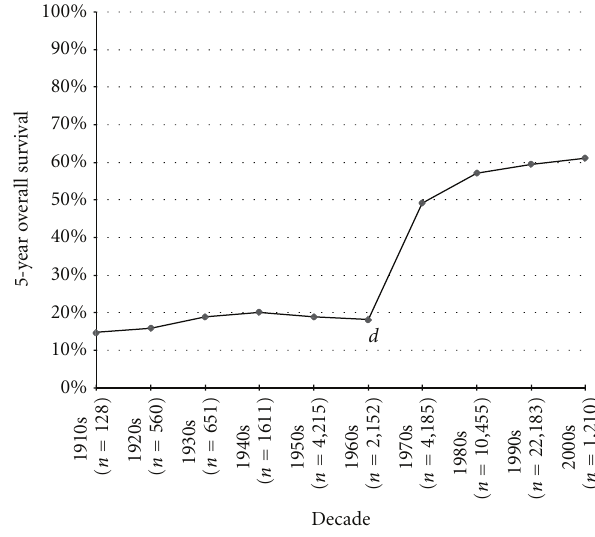
Figure 1: Osteosarcoma 5-year overall survival.